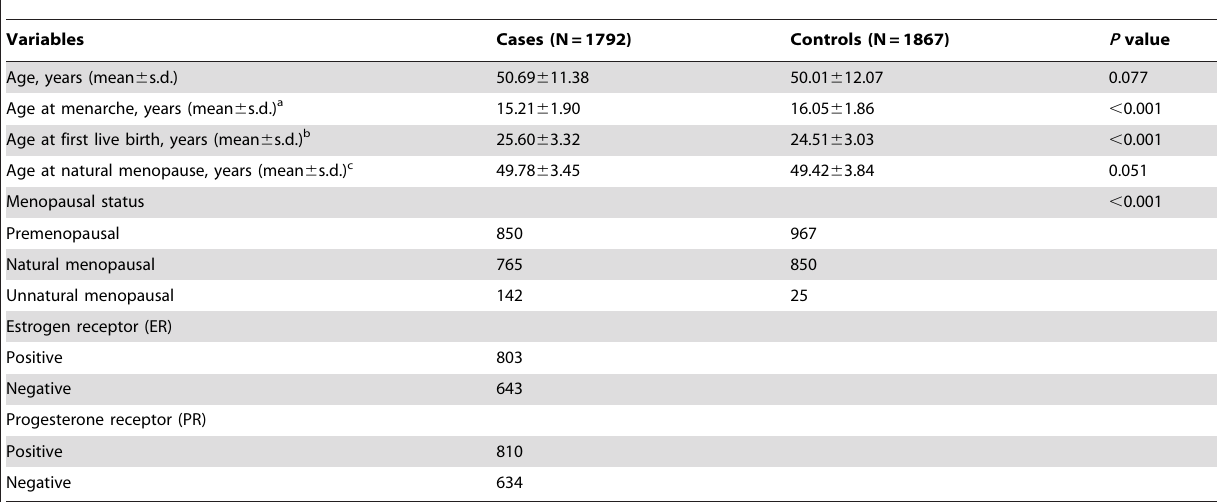
Table 1. Distributions of select variables between breast cancer cases and cancer-free controls.